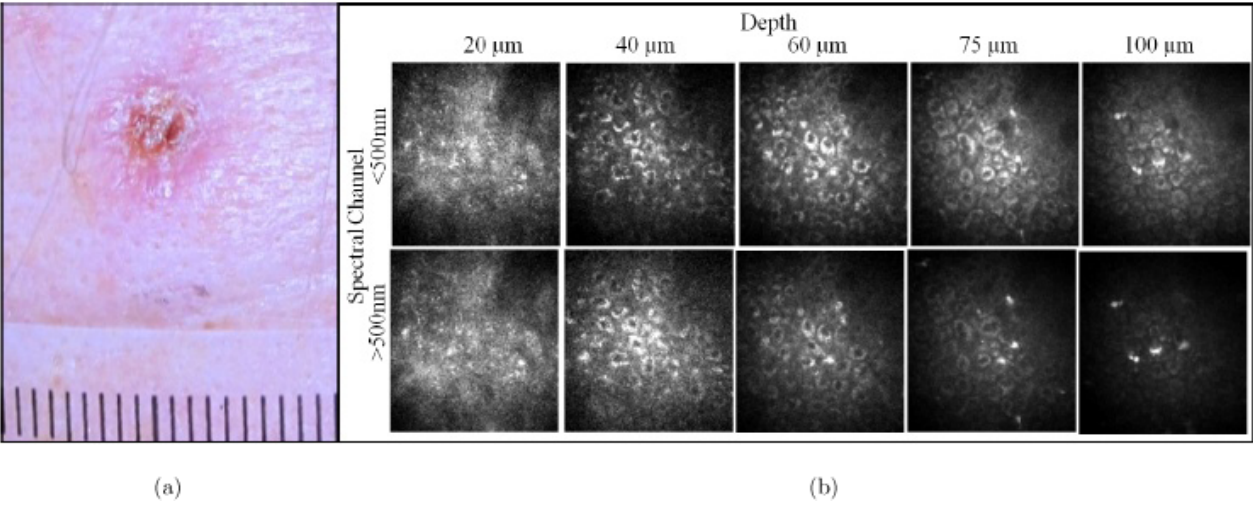
Fig. 3. (a) BCC, (b) Fluorescence lifetime images at di®erent depths, imaging ¯eld of view 177 (cid:1) 177 (cid:1) m 2 . 24 (Permission has been granted by